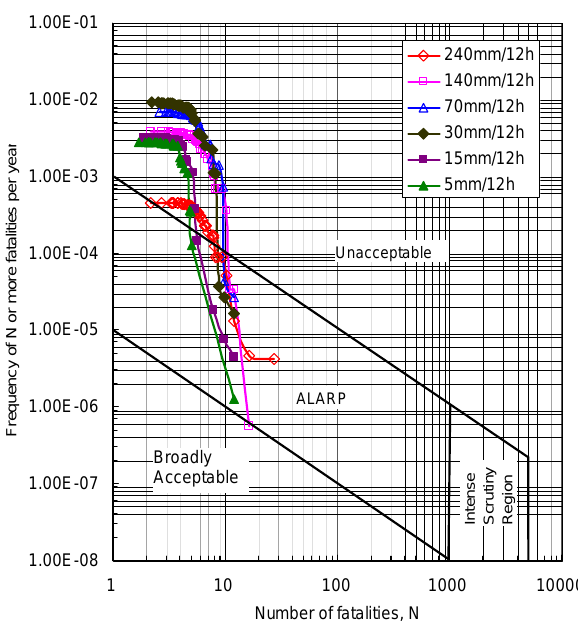
Fig. 15. F-N curves for K1–K18 shortly after the earthquake in six rainfall scenarios.